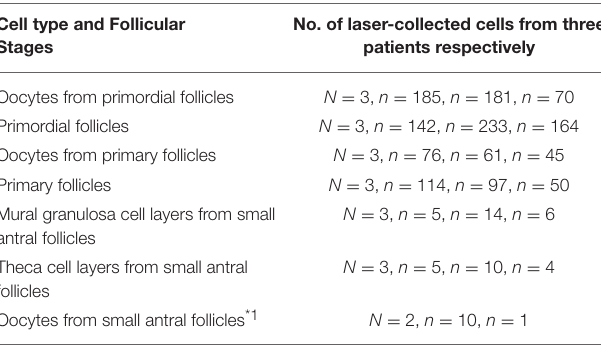
TABLE 1 | Numbers of oocytes, follicles, and other somatic cells analyzed in RNA–seq. in three different patients. Cell type and Follicular